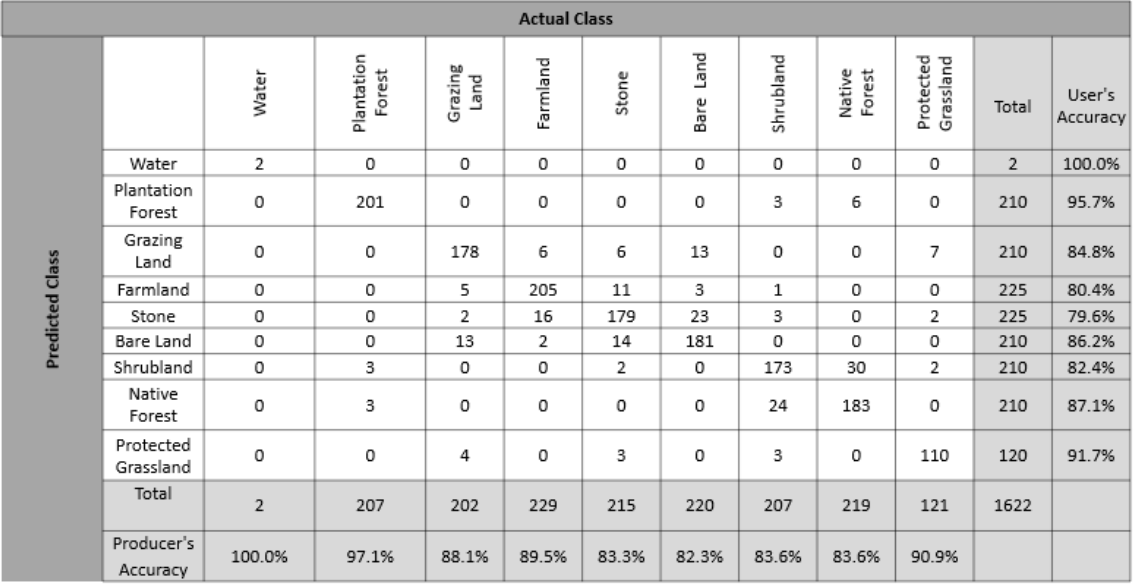
Table A1.1. The confusion matrix for the supervised classification demonstrates the ability of the model to correctly classify a set of training points for each land class using a cross-validation approach. The kappa value for this classification was